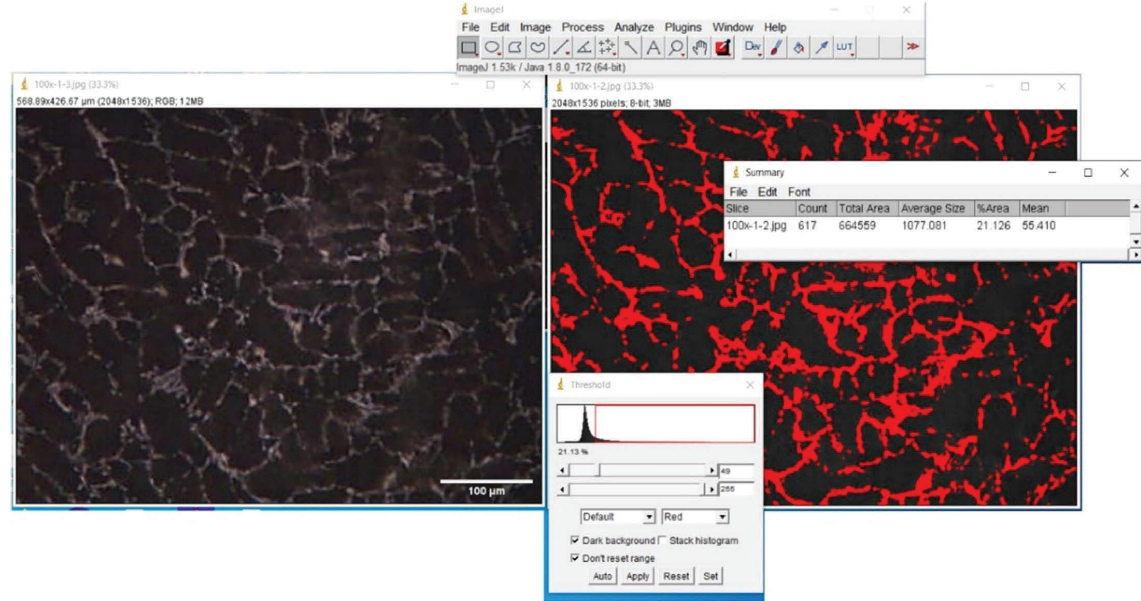
Figure 10: Utilizing the ImageJ program for calculating the total volume fraction of